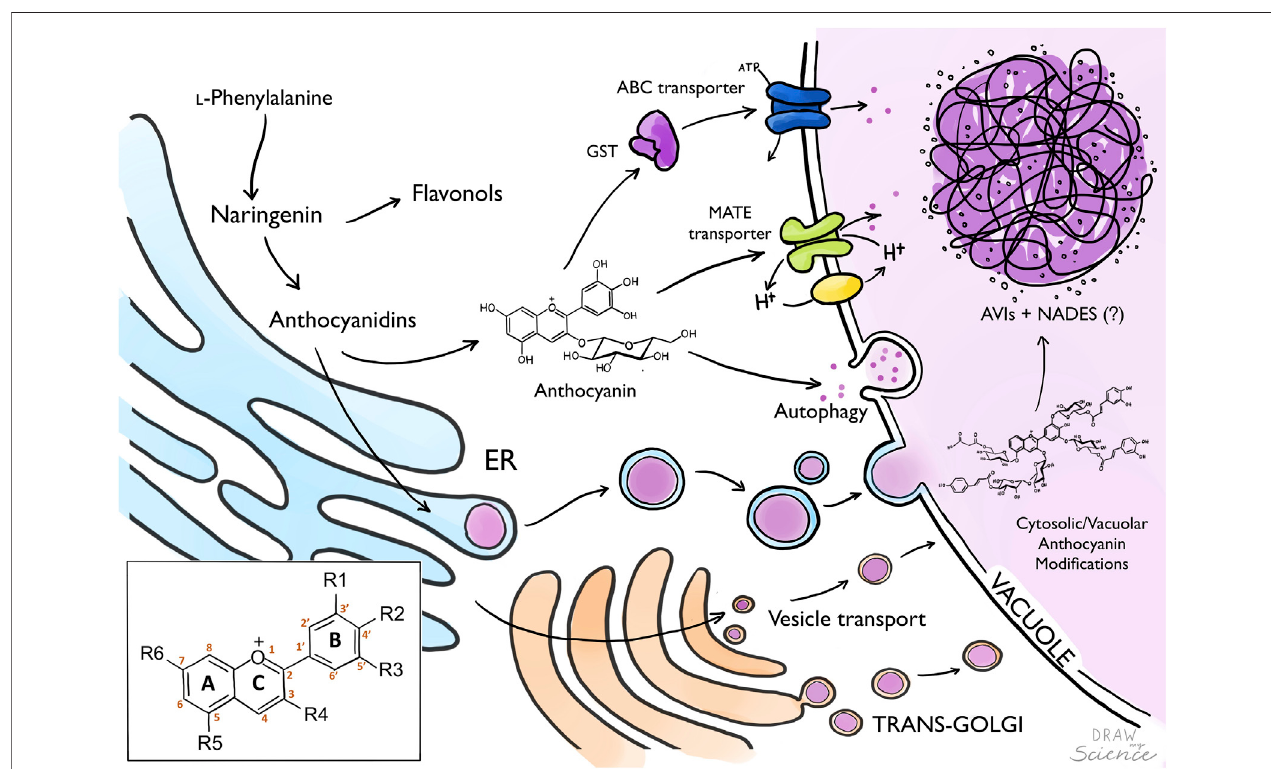
FIGURE 1 | From anthocyanin biosynthesis to storage as AVIs. Biosynthesis of anthocyanins occurs in the Endoplasmatic Reticulum (ER), where anthocyanidins are later glycosylated to generate anthocyanins which are translocated to the vacuole. Anthocyanins are transported into the vacuole by tonoplast localized transport proteins (MATE, ABC-transporters) potentially mediated byGlutathione-S-Transferase. Alternatively, anthocyanins are transported into the vacuole via vesicles from the ER, Golgi or autophagy. Anthocyanin modi fi cation can occur in the cytosol or inside the vacuole. Formation of Anthocyanin Vacuolar Inclusions (AVIs) might be mediatedbythepresenceofNaturalDeepEutecticSolvents(NADES)composedbyprimarymetabolitestranslocatedtothevacuole.Box:Anthocyanidinbackbonewith A, B and C ring, and six common sites for anthocyanin modi fi cations marked with R.